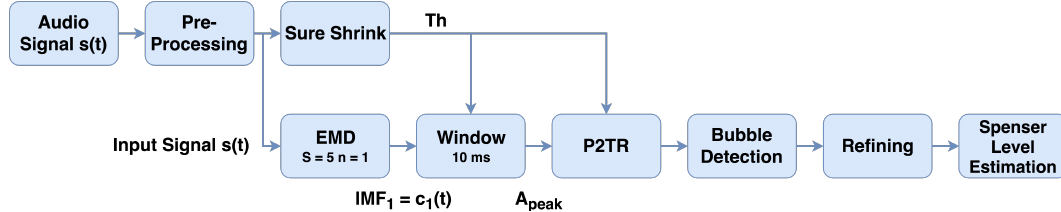
Figure 2. Block diagram of the main steps of the algorithm.